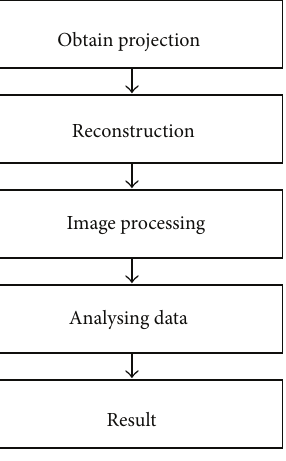
Figure 1: Image processing.